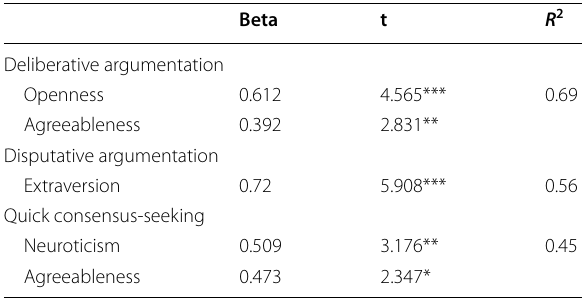
Table 6 Stepwise regression model for predicting students’